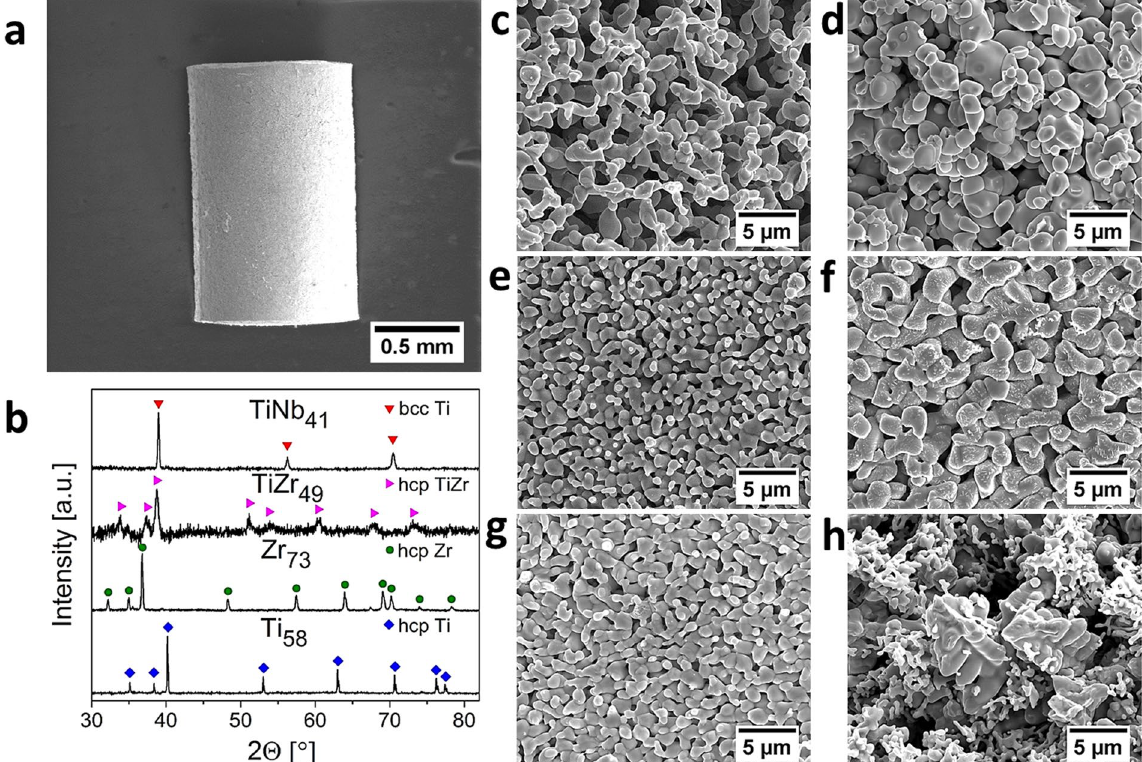
Figure 1. Characterization of porous samples. ( a ) Macroscopic specimen geometry. ( b ) X-ray diffractograms of porous Ti 58 , TiZr 49 , Zr 73 , and TiNb 41 . The diffractograms of Ti 35 and Ti 62 are similar to that of Ti 58 and not shown. Crystallographic phases are marked in the graph. Scanning electron micrographs of Cleavage surfaces of different porous alloys: Ti 35 ( c ), Zr 73 ( d ), Ti 58 ( e ), TiZr 49 ( f ), Ti 62 ( g ) and TiNb 41 ( h ). The number in the sample name reflects its solid